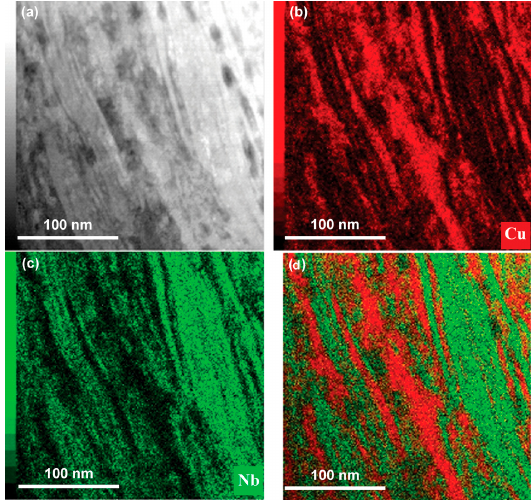
Figure 14. BF-STEM image ( a ) of the sample deformed by HPT to N = 4 and X-ray element distribution maps: copper ( b ), niobium ( c ), superposition of Cu and Nb ( d ).